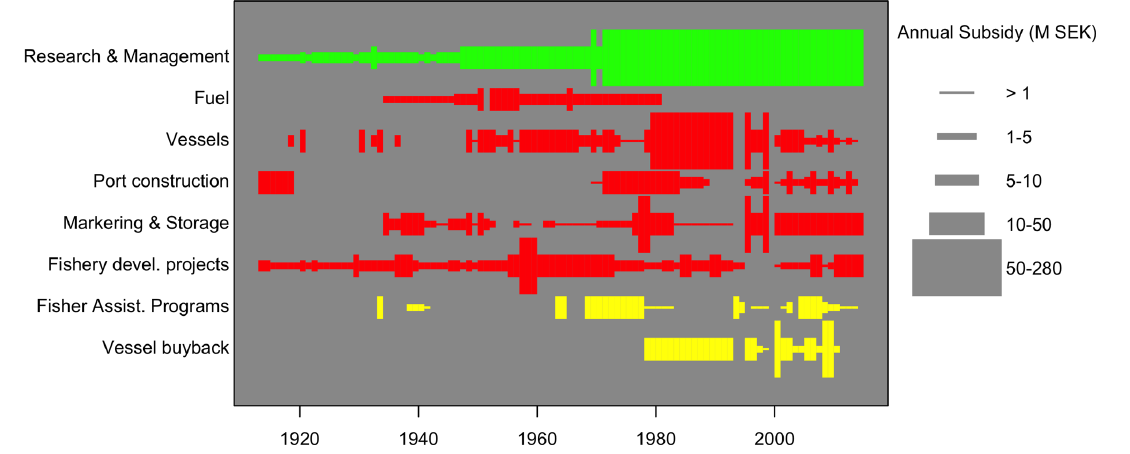
Fig. 1 . Availability of different categories of subsidies over time. Green color denotes beneficial subsidies, red capacity-enhancing, and yellow ambiguous subsidies. For full description see Table A1.1. M SEK = millions, Swedish Krona.